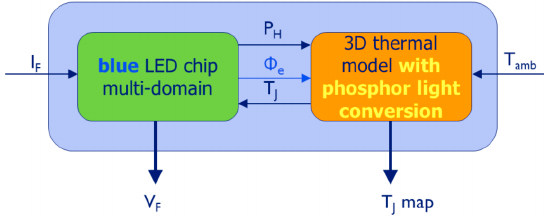
Figure 3. Application of a chip-level multi-domain LED model in a relaxation type implementation of an electro-thermal-optical solver, with a detailed 3D thermal model of the CoB LED chips’ thermal environment completed with a thermo-optical model describing the light conversion and heat generation in the phosphor. For the explanation of symbols used in this figure see the Appendix.